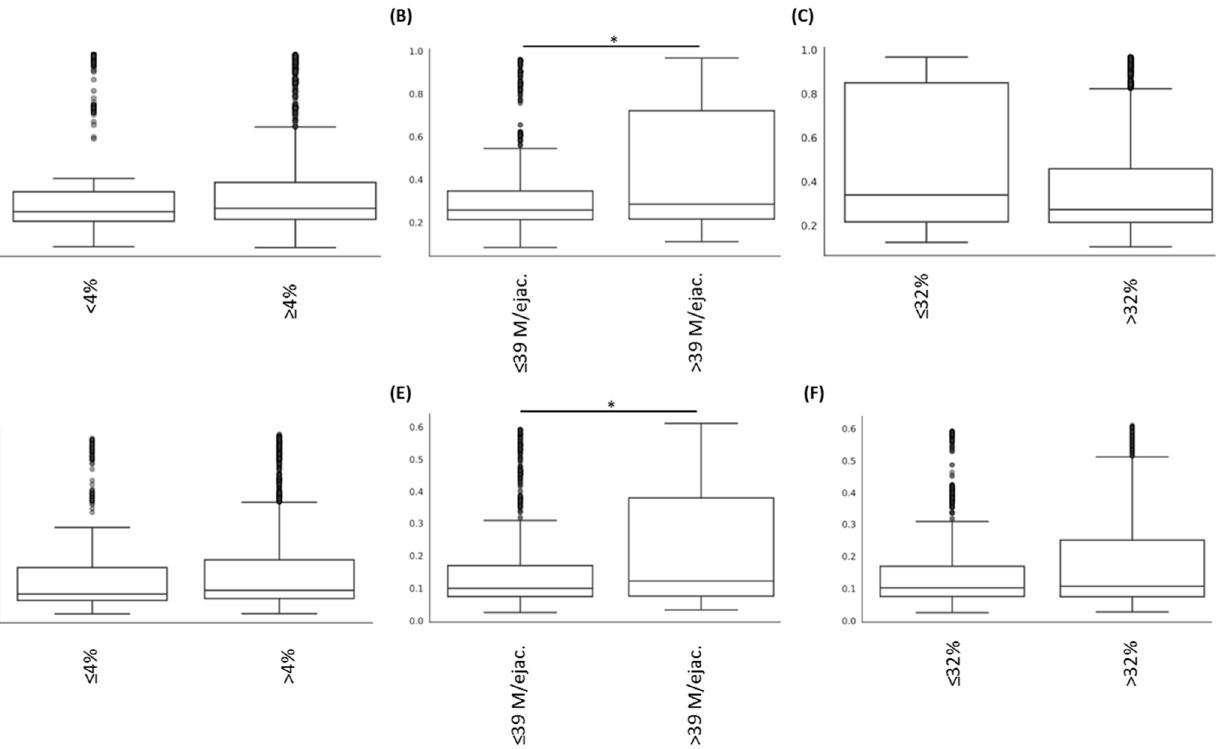
Figure 3. Comparison of beta diversities, determined with different indexes (( A – C ): Bray–Curtis indexes and ( D – F ): Unifrac weighted indexes) according to the “Morphology” ( A , D ); “sperm count” ( B , E ), and “motility” ( C , F ) parameters. The comparison between groups with abnormal vs. normal sperm count demonstrated significant difference (* p < 0.05).